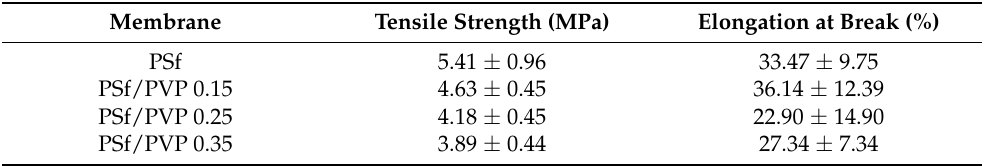
Table 4. The results of mechanical strength test of the membranes.